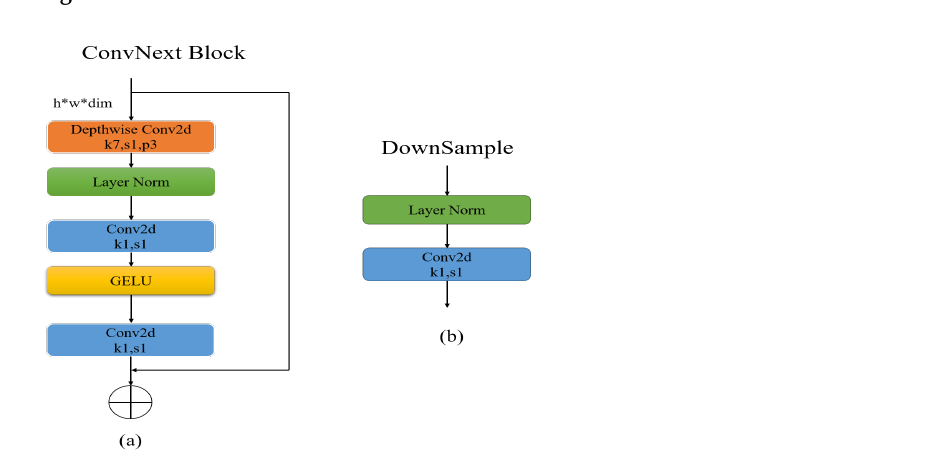
Figure 4. Feature network design. The * stands for multiplication ( a ) ConvNeXt block’s structure; ( b ) downsample structure, where k represents the convolution kernel size, s represents the step size, and p represents the